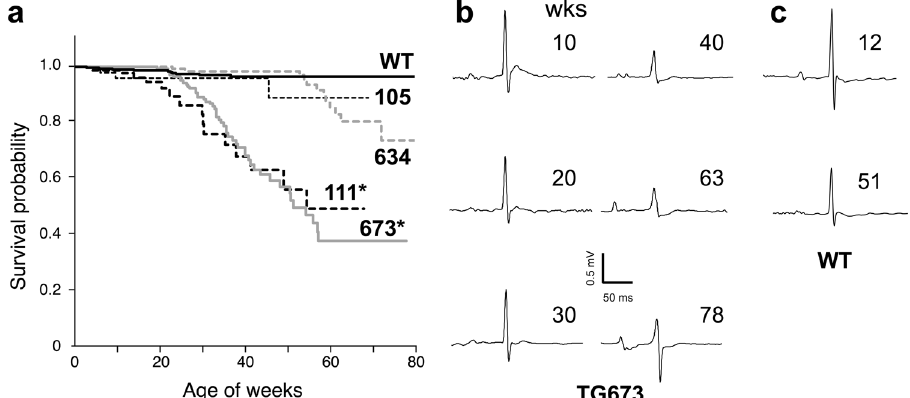
Figure 1. Overall survival among Kir6.1TG mice and changes in ECG traces. ( a ) Kaplan-Meier curves for overall survival among four Kir6.1TG lines. Line 673 and 634 expresses wild-type Kir6.1, while line 111 and 105 expresses mutant Kir6.1 (S422L). These lines derived from the distinct founders. Each curve enrolled the following number of mice, WT:1737, 634:247, 673:327, 105:50, 111:87, respectively. * p < 0.05 vs. WT. ( b , c ) Representative ECG traces from Kir6.1TG (line 673) mice ( b ) and WT control ( c ) at different stages of life. Surface ECG (lead-II) was recorded from the anesthetized